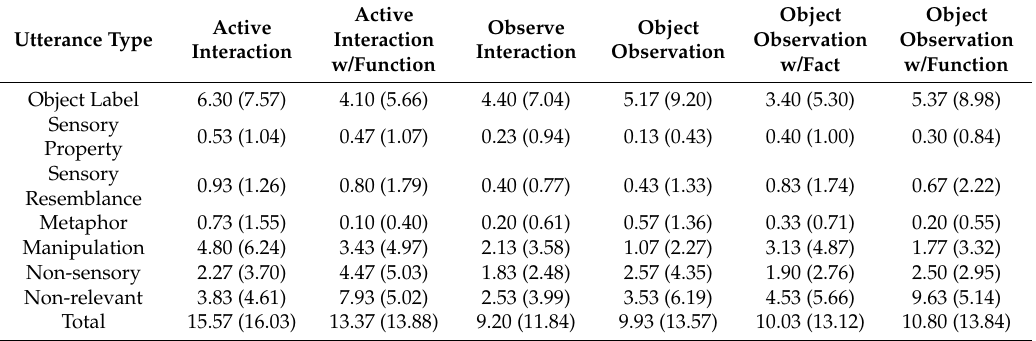
Table 2. Children’s mean numbers of utterances of each type produced during the learning phase of Experiment